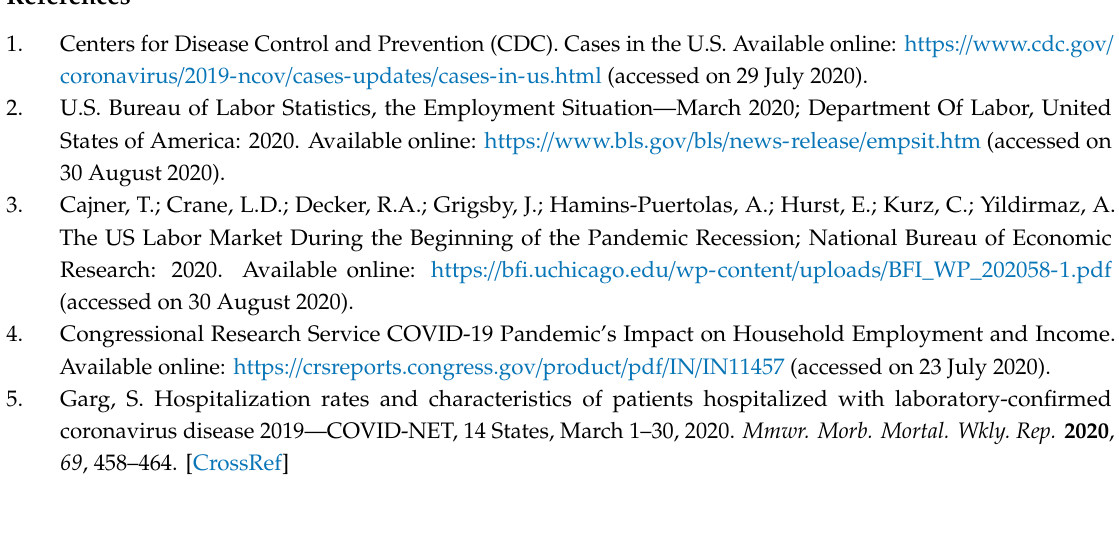
Figure S1: Trends of six movement categories using google mobility report data, 15 February to 12 June 2020, United